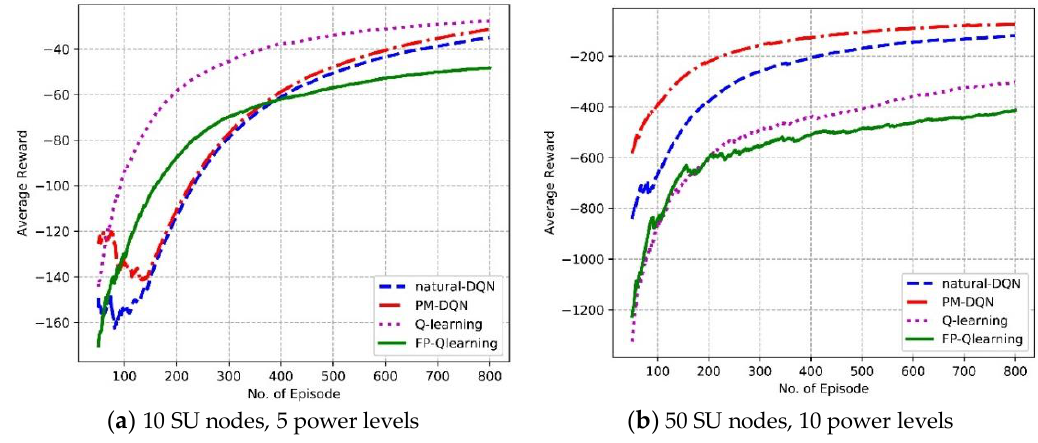
Figure 7. Average reward of the SU agent vs. the number of episodes.